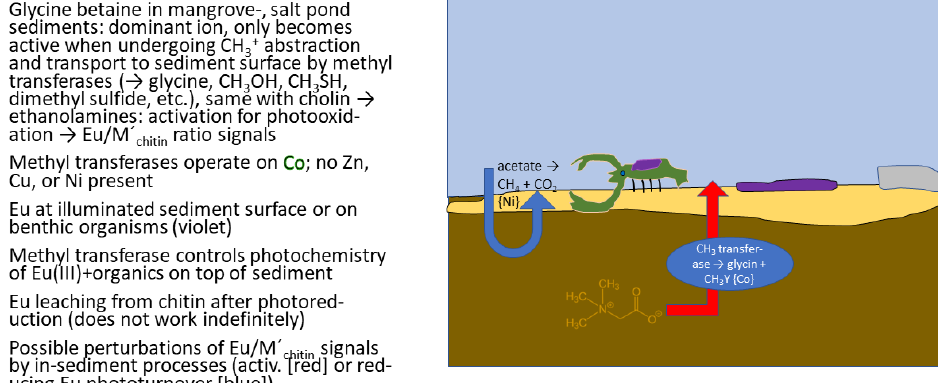
Figure 13. Activities of methyl transferases; CH 4 -making Ni proteins control conversion of methyl compounds CH 3 Z including acetate by Eu(III)* (violet) on top of sediment (adsorption of Eu, e.g., to chitin litter, Ti-rich sand, and benthic organisms).